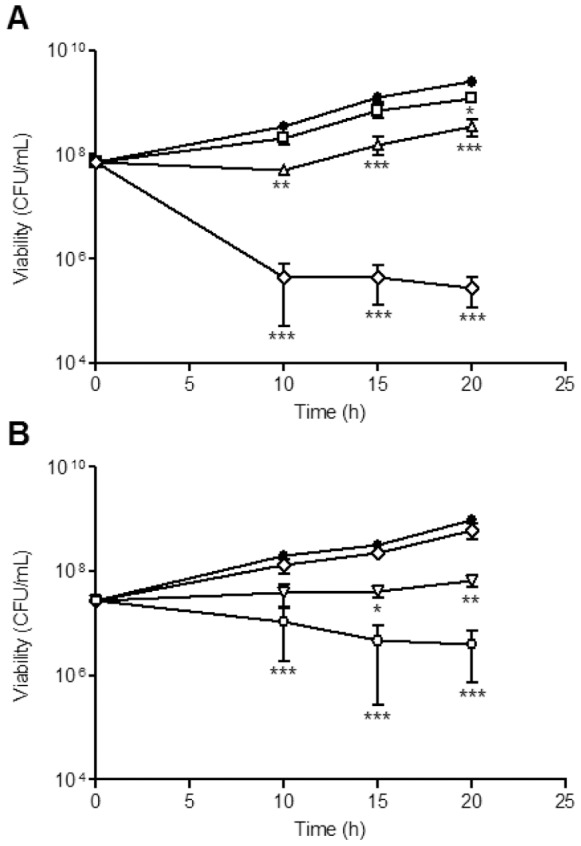
CORMs affect H. pylori viability.Cell viability of H. pylori 26695 left untreated (filled circle) and treated with 100, 150 and 200 mg/L CORM-2 (open square, triangle and diamond, respectively) (A), and exposed to 120, 240 and 300 mg/L CORM-3 (open diamond, inverted triangle and circle, respectively) (B). The number of viable cells were determined for four biological samples and are expressed as means ± SE. *p<0.05, **p<0.01 and ***p<0.001 (Two-way ANOVA and Bonferroni test).